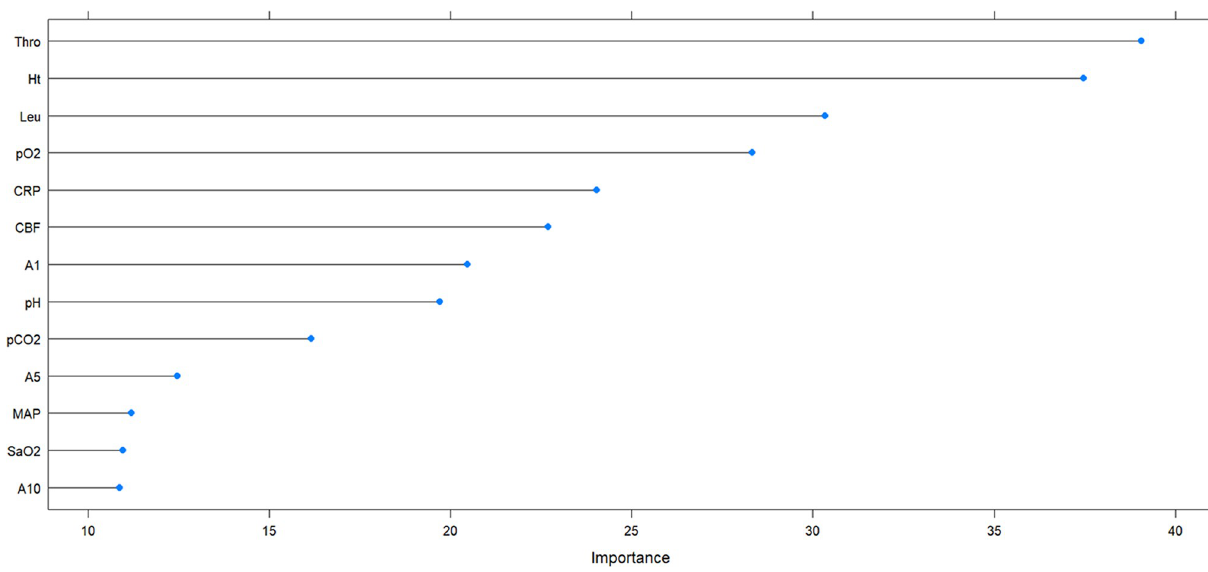
Fig 4. Variable importance plot for very preterm infants with 27 to 30